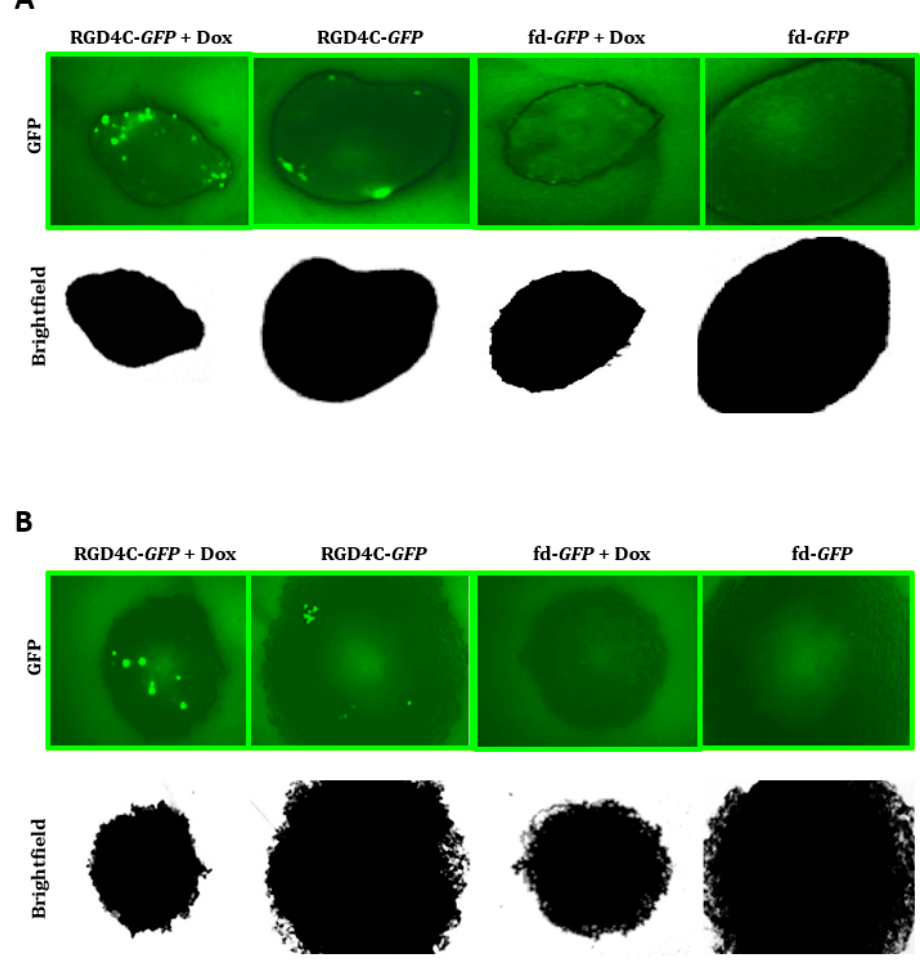
Figure 5. Dox increases RGD4C / AAVP transduction of 9L and M21 tumor spheres. 9L ( A ) and M21 ( B ) cells, 5 × 10 3 , were seeded into a 96-well ultra-low attachment surface plate in 200- µ L complete medium. After 48 h, spheres were established in each well. The spheres were then transduced with targeted RGD4C- GFP or fd- GFP control nontargeted vectors in the presence or absence of doxorubicin (0.5 µ M for 9L and 0.6 µ M for M21 spheres). GFP expression was evaluated at day 10 post-transduction by using a fluorescence microscope. Original magnification ×20 for panels A and B.